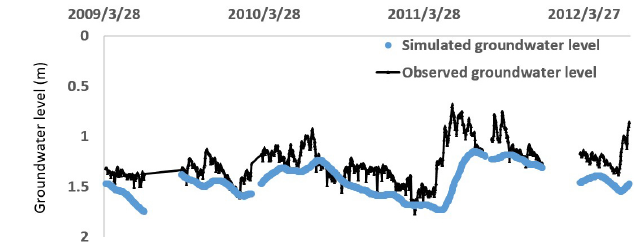
Figure 5. Simulated and estimated groundwater level.